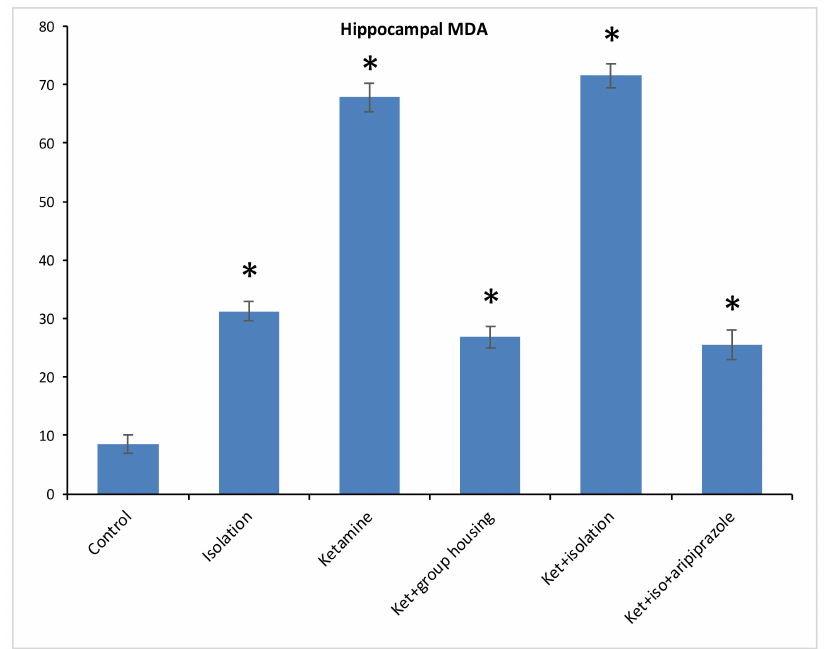
Figure 5. The effects of social isolation, ketamine, combined ketamine and social isolation, and combined ketamine, social isolation, and aripiprazole treatment on MDA-specific activity in hippocampus brain samples (measured in mmol/mg of protein). The values are mean ± SD ( n = 7 per group). * Significantly different when compared to control group ( p < 0.05).